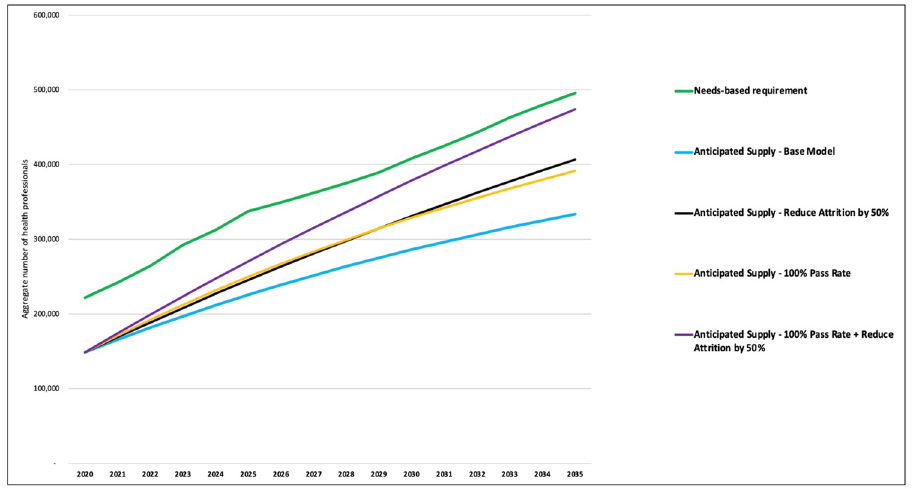
Fig 5. One-way sensitivity analysis of supply-side